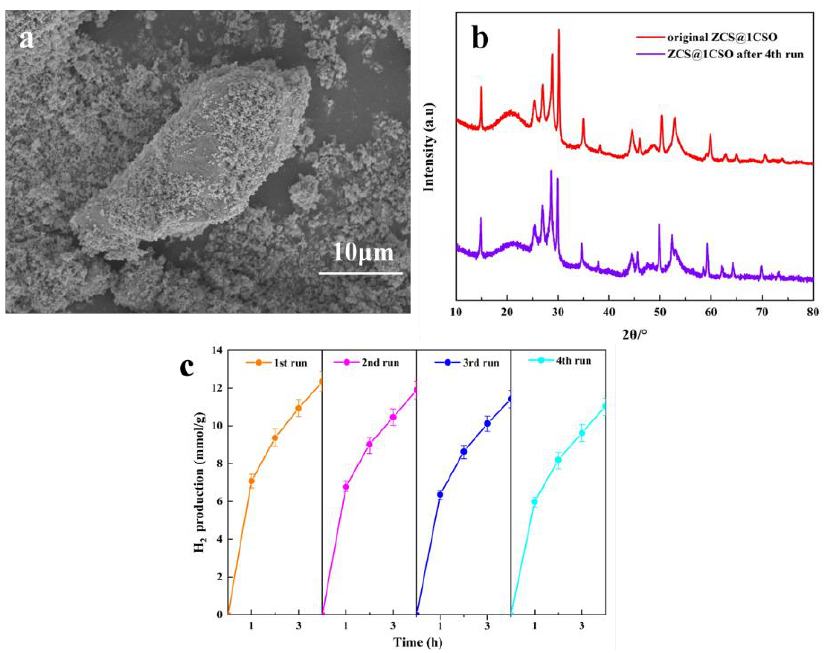
Figure 10. The SEM ( a ) and XRD ( b ) analysis results of ZCS@1CSO after its fourth run and H 2 production efficiency under the ZCS@1CSO photocatalytic system for four runs ( c ).